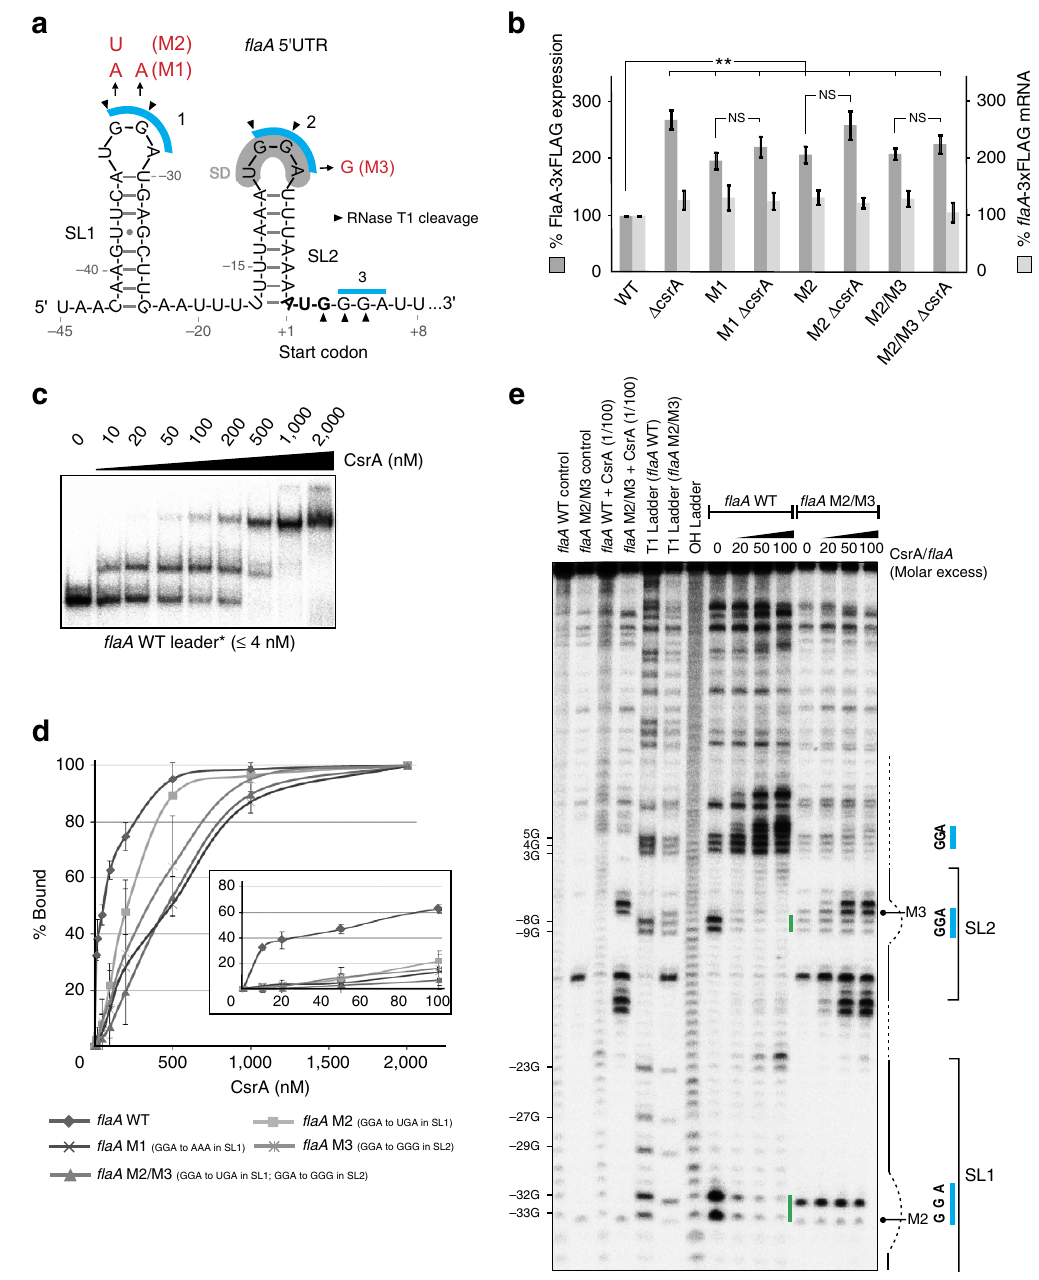
Figure 2 | CsrA represses flaA translation by binding to its 5 0 UTR. ( a ) Predicted secondary structure of the flaA leader using Mfold 74 . Blue bars indicate GGA motifs; grey: SD sequence. Black triangles indicate RNase T1 cleavages from the structure probing in c . ( b ) Western blot quantification ( n ¼ 5 biological replicates) of FlaA with a C-terminal 3xFLAG epitope tag integrated at its native locus (FlaA-3xFLAG) and northern blot analysis of flaA mRNA ( n ¼ 3 biological replicates) in D csrA and various flaA 5 0 UTR mutant strains. Shown is the mean ± s.e.m (** P o 0.01 using Student’s t -test, NS: not significant). Mutations are depicted in red in a . ( c ) Gel-shift assays using B 0.04pmol in vitro -transcribed and 5 0 end-labelled flaA leader ( (cid:3) 45 to þ 99 relative to the start codon) with increasing concentrations of CsrA. ( d ) Affinity binding curves determined by gel-shift assays for 32 P-labelled flaA WTand mutant leaders ( r 4nM) based on three replicates. The inset represents an enlargement of the binding curves for low CsrA concentrations. Shown is the mean ± s.d. ( e ) Footprinting assays of B 0.2pmol 32 P-labelled flaA WT and flaA M2/M3 mutant leaders in the absence or presence of increasing CsrA concentrations (molar excess of 0, 20, 50 and 100 CsrA) using RNase T1. Untreated flaA leader alone or incubated with 100-fold excess of CsrA served as controls and RNase T1- or alkali (OH)-digested flaA leader as ladders, respectively. Blue lines: GGA motifs; green lines: protection from RNA cleavage upon addition of CsrA. The secondary structure of the flaA leader according to a is depicted on the right.